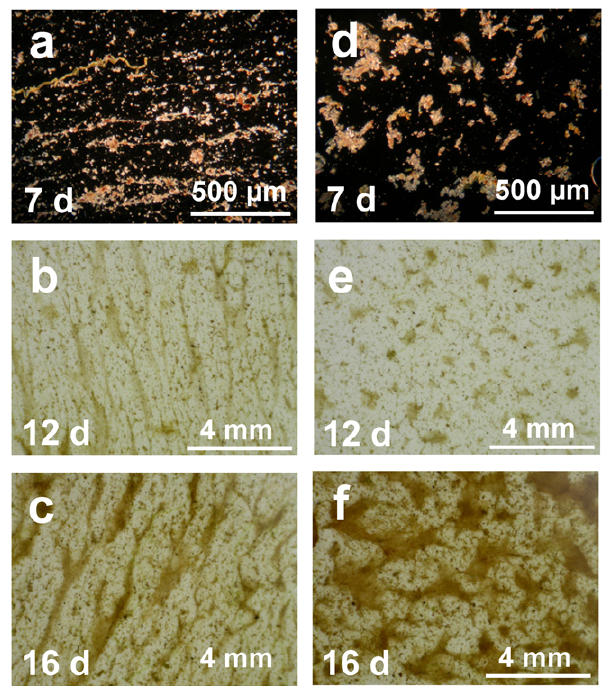
Figure 3. Microbial biofilm structure. Microscopic darkfield and orthophotographic images of biofilms from the crest ( a–c ) and the trough ( d–f ) between 2 consecutive bedforms. Arrows on indicate main flow direction, numbers indicate biofilm age in days.